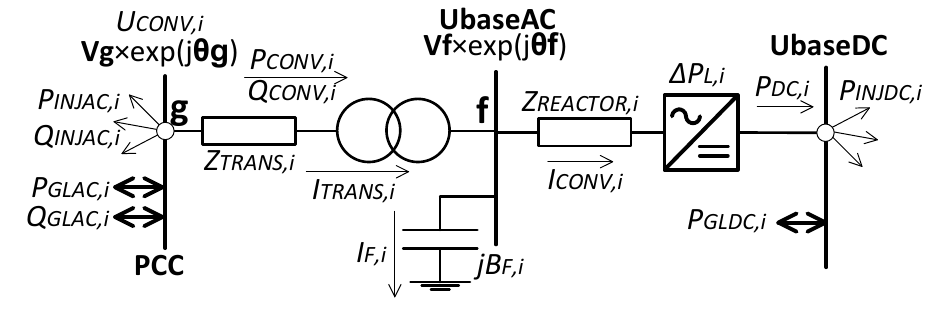
Figure 5. Steady state VSC station model.